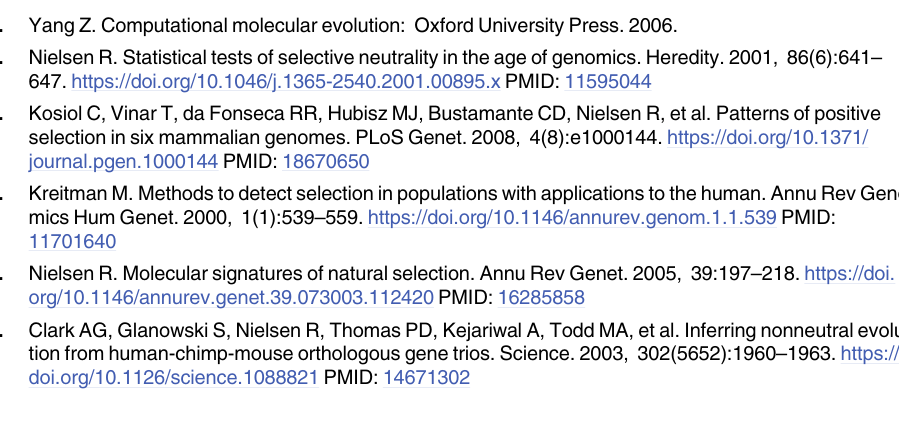
S16 Fig. Comparisons of DNA methylation level of the PSGs with constitutive expression in six B. rapa tissues (roots, stems, leaves, flowers, siliques and callus) at CG (a), CHG (b) and CHH (c) contexts. S1 Table. The number of PSGs and their proportion in the ten chromosomes. S2 Table. The list of enriched KEGG genes and auxin-related genes. S3 Table. The number of expressed PSGs in different tissues and chromosomes. S4 Table. The p values of PSGs and random non-PSGs in five different genomic regions analyzed by Kruskal-Wallis rank sum